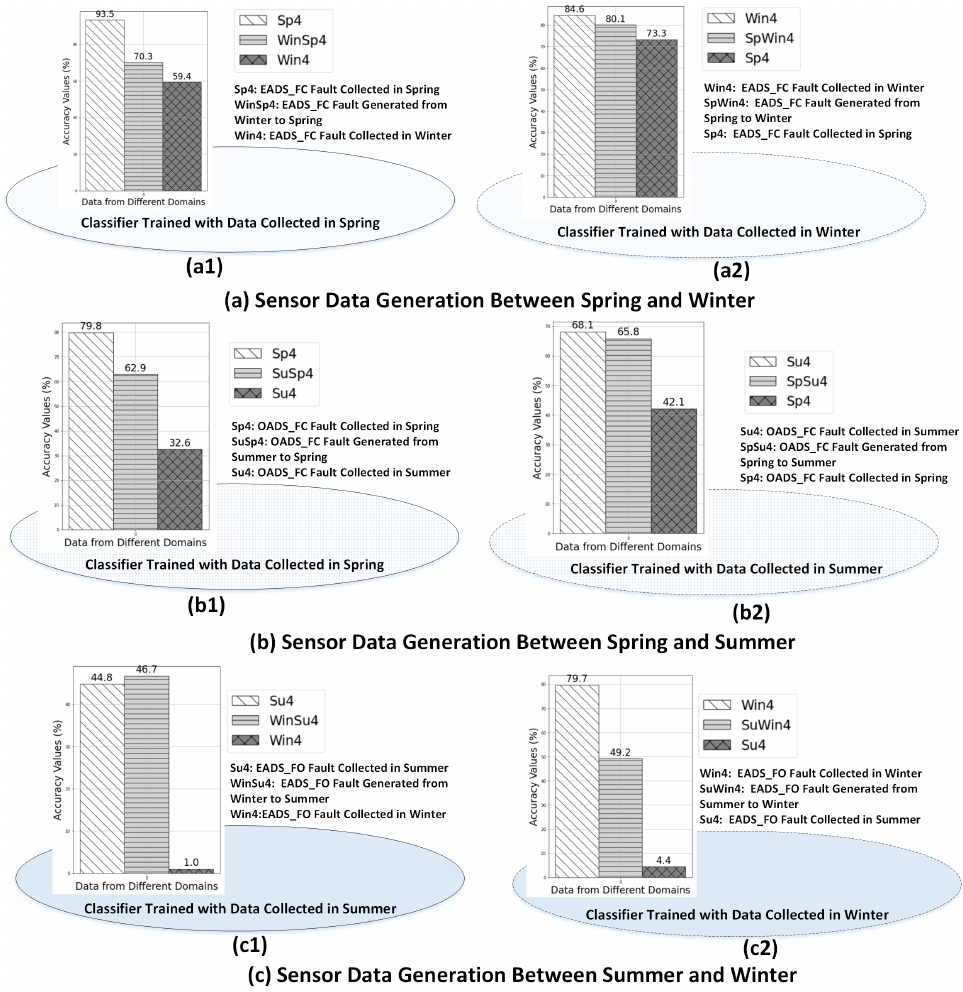
Figure 6. Summary of the classification performance (identification ratios (%)) of classifiers trained with ground truth data on identifying data obtained from different sources. ( a ): Spring ↔ Winter.